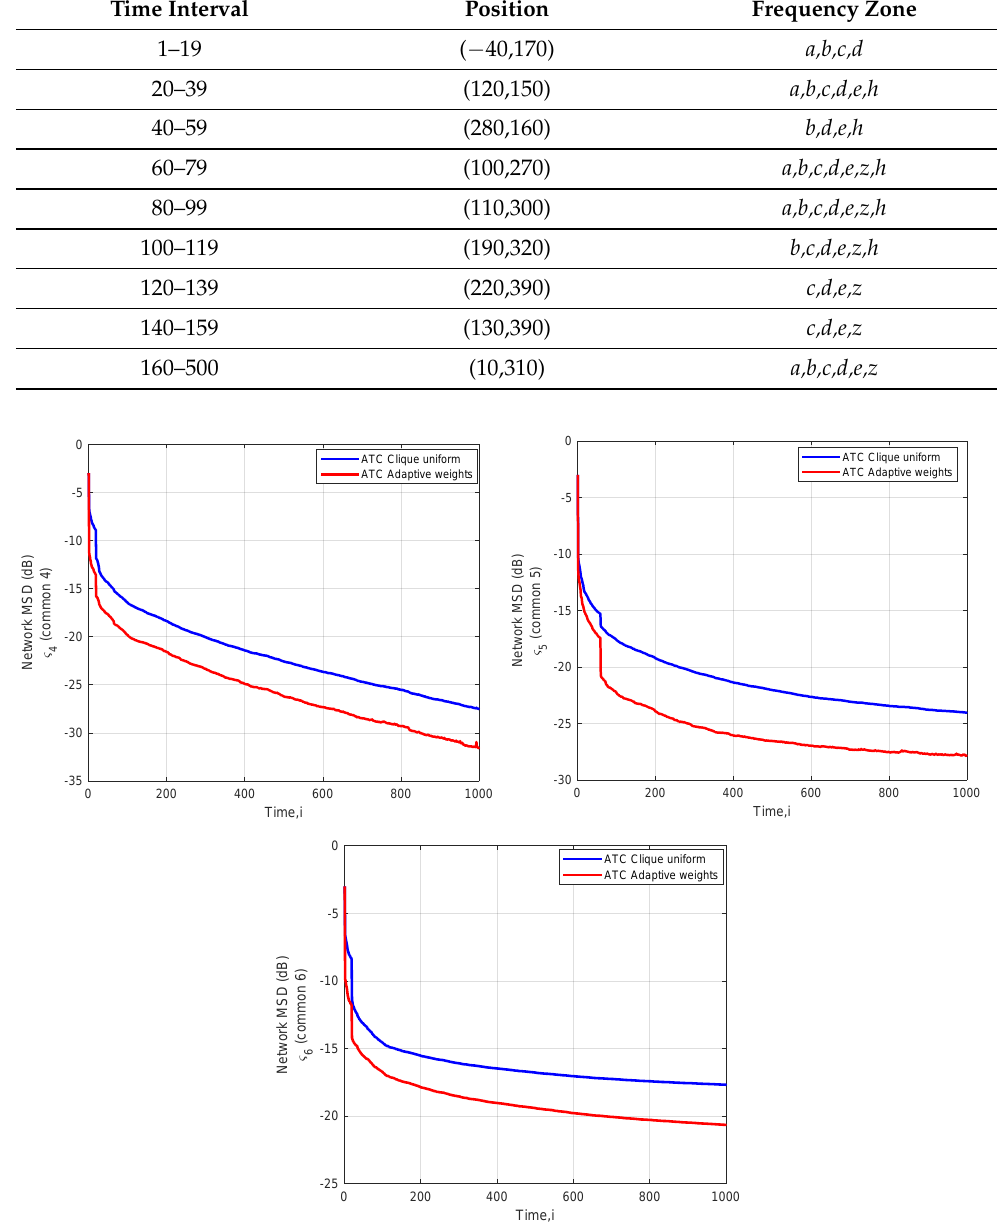
Figure 7. Network MSD (dB) for the common interest vectors ς